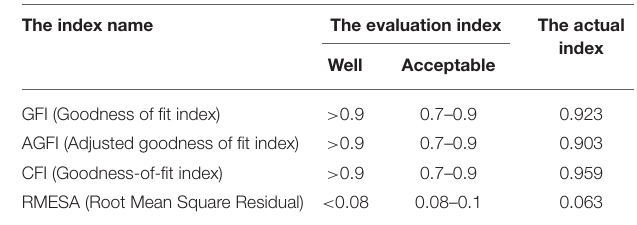
TABLE 2 | Reliability and validity of instruments. Main variable